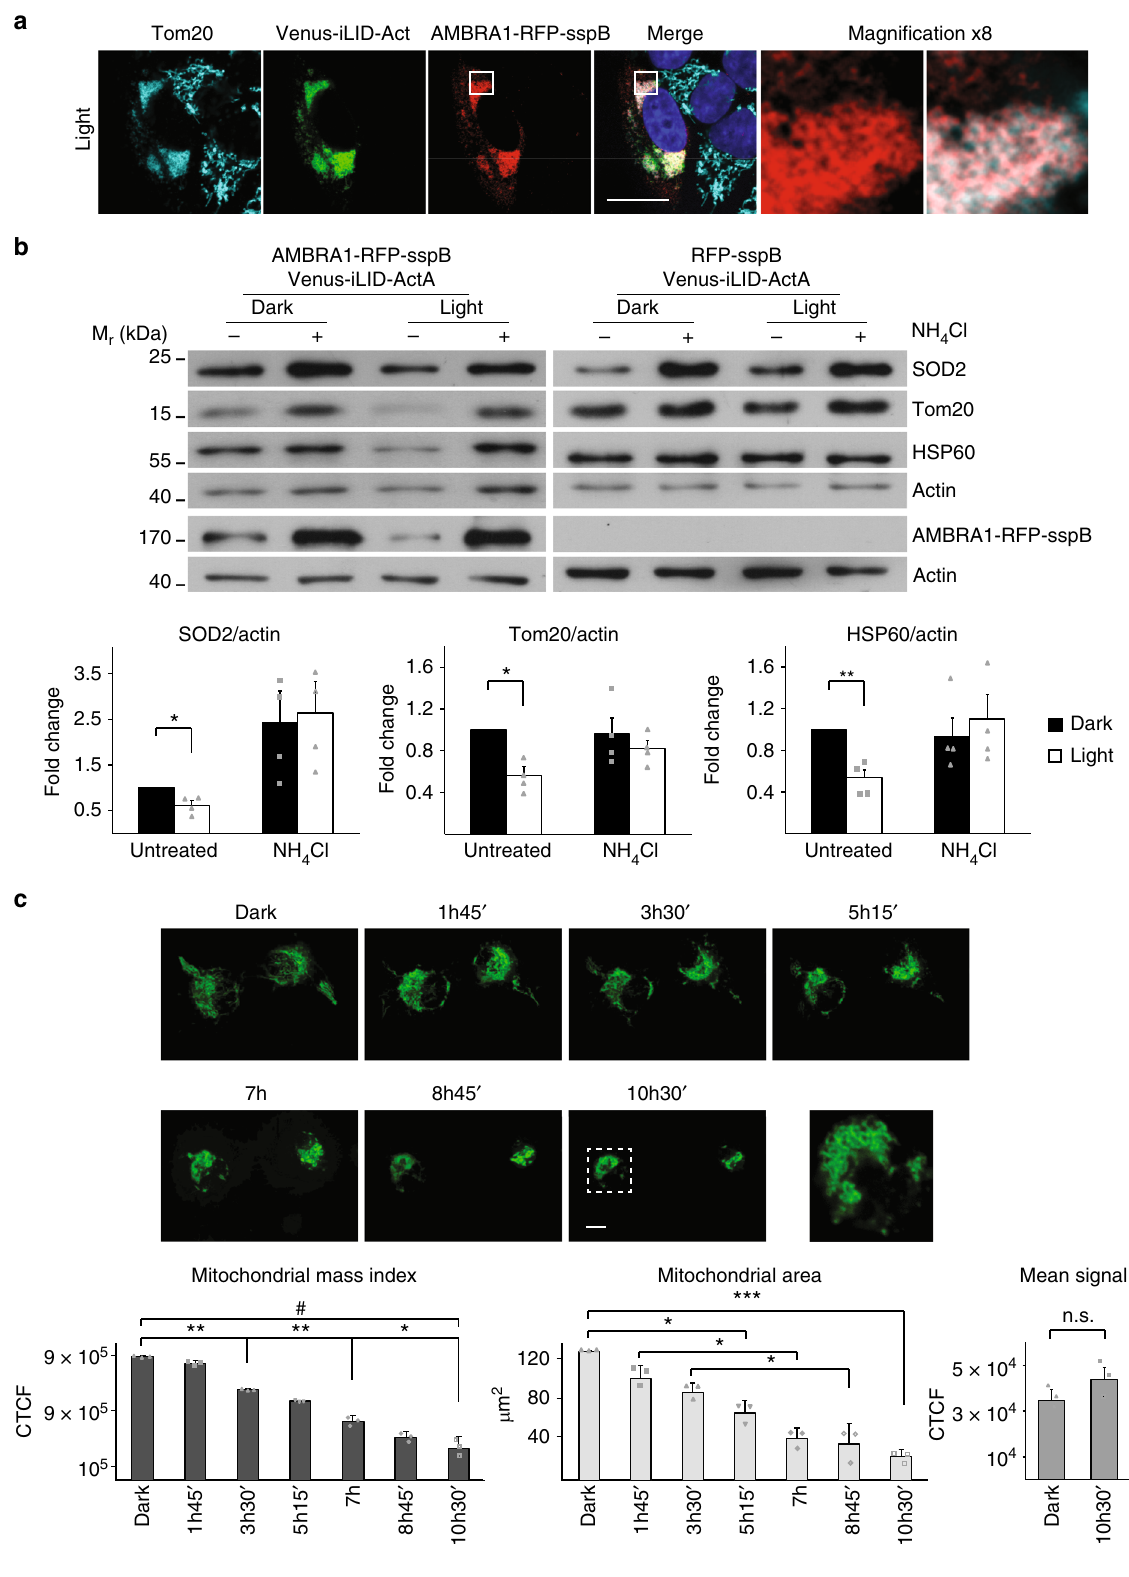
Venus-iLID-ActA/AMBRA1-RFP-sspB co-expressing cells. order to estimate mitochondrial mass in the two given conditions. As controls, cells were also kept either 48 h in the dark or 48 h under blue light, respectively; additionally, the experiment was repeated in Venus-iLID-ActA/RFP-sspB co-expressing cells to highlight the speci fi city of SOD2 decrease, as explained